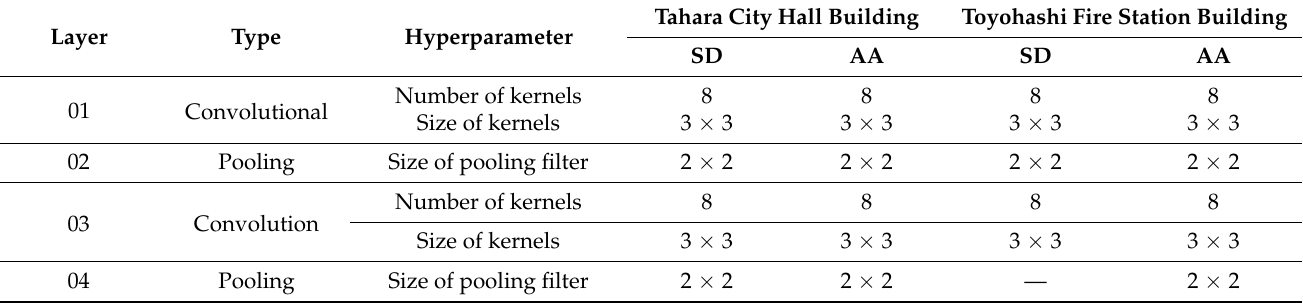
Table 2. Hyperparameters of CNN